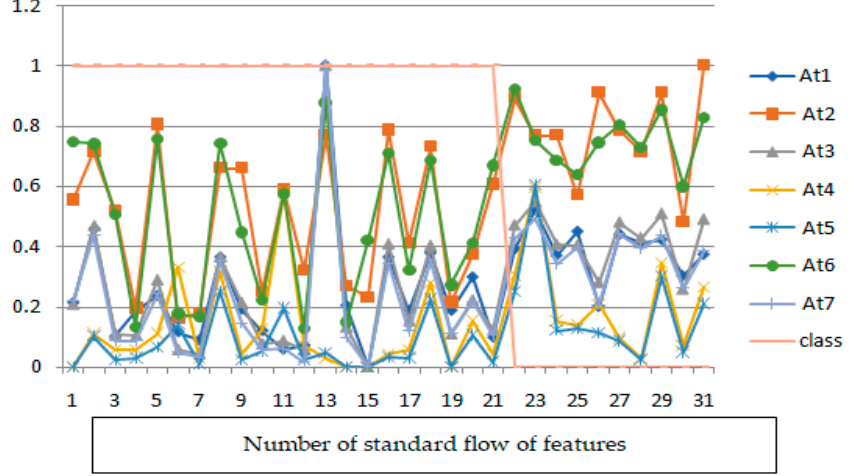
Figure 9. Class-wise conversation rate.